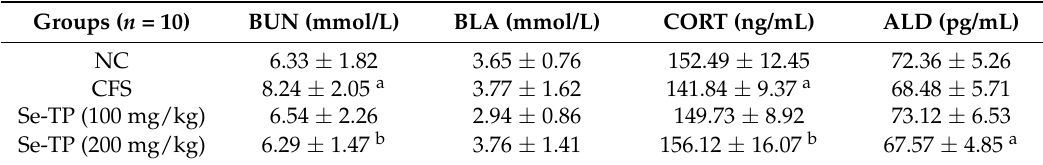
Table 2. Analysis of serum metabolites.